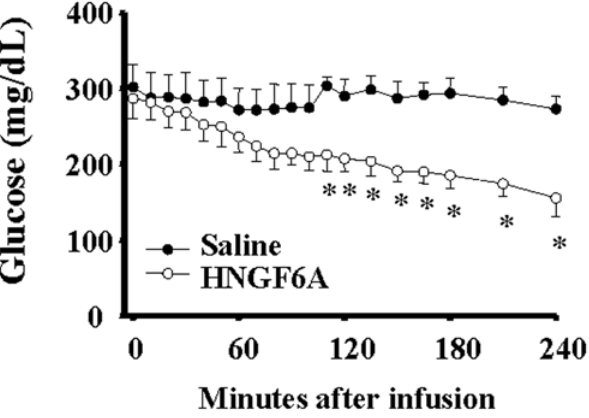
Figure 7. Effect of a single IV dose of HNGF6A on blood glucose levels in chronically catheterized, unstressed Zucker diabetic fatty (ZDF) rats over 4 hours. *Significantly different than saline controls, P , 0.05.